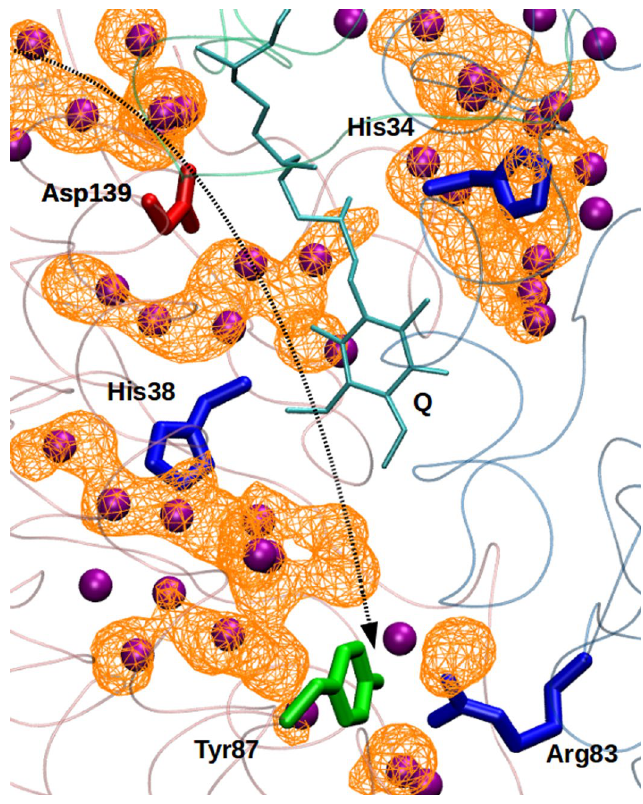
Figure 6. Hydration of the Nqo4 subunit. The water occupancy map is shown as a wireframe plotted with a surface isovalue of 0.2. The key amino acid residues of Nqo4 (His34, His38, Tyr87 and Asp139) and Nqo6 (Arg83), water molecules (purple), and a Q molecule (QH 2 ) are also shown. The snapshot is obtained from model # II, and hydrogens are not shown for clarity. The dotted arrow shows a putative (‘premature’) proton transfer pathway towards deprotonated Tyr87 from the bulk (N-side). See also Supplementary Fig.